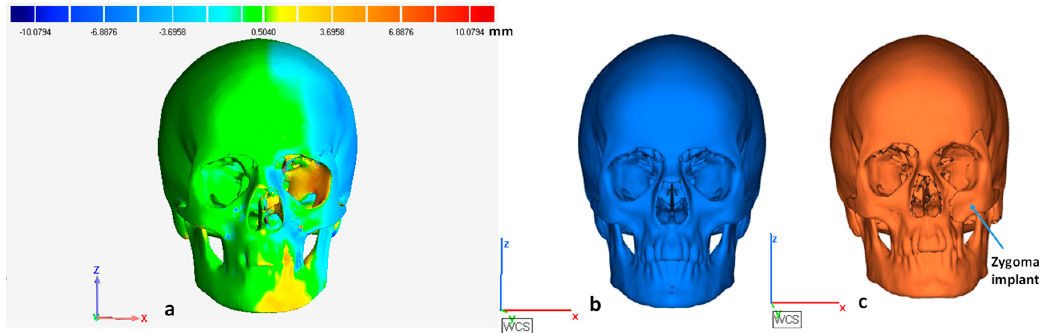
Figure 12. ( a ) 3D inspection results of model deviation between the ( b ) mirror reconstruction model and ( c ) zygomatic implant model.